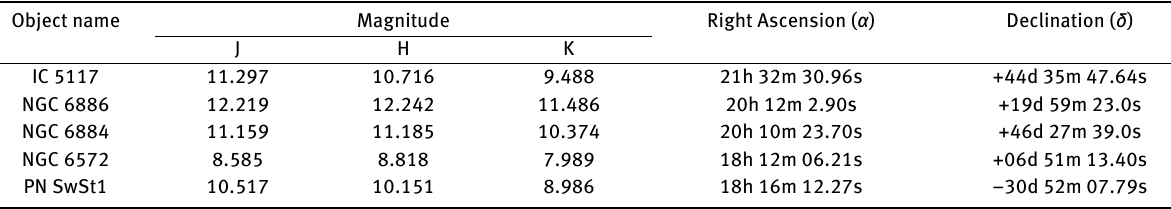
Table 3. Some nebulae and their right ascension ( α ) and declination data ( δ